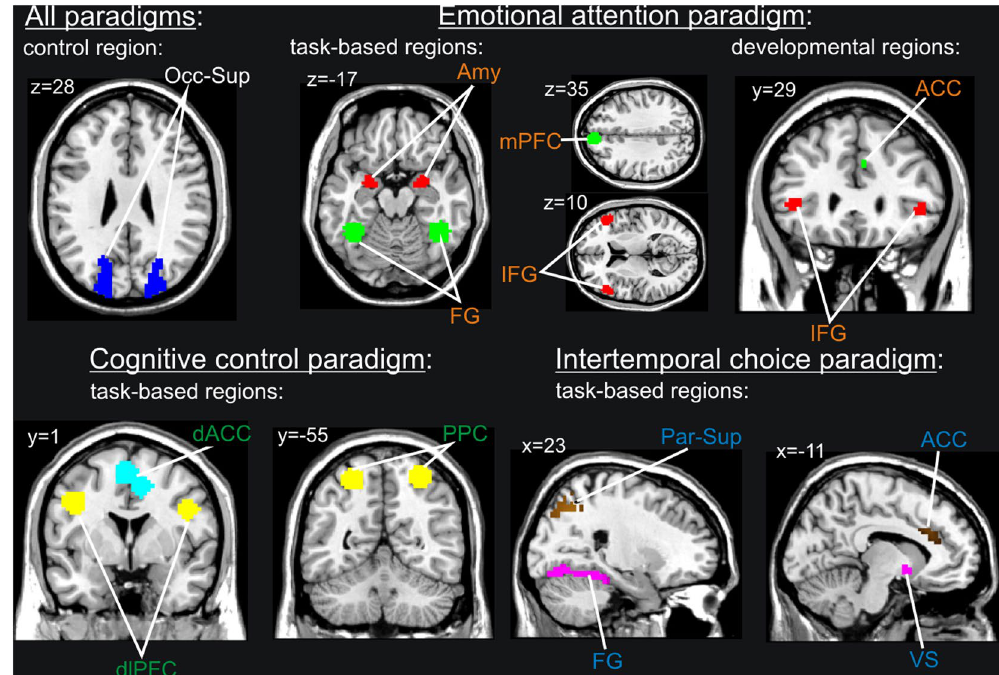
Figure 4. Regions of interest that were used to calculate ICC for all paradigms. The control regions for all paradigms were the left and right superior occipital